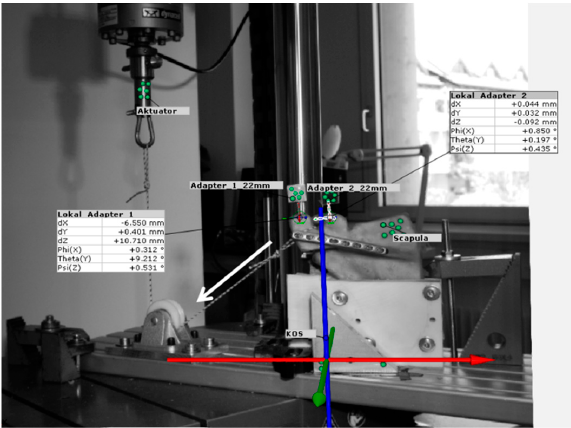
Figure 3. Test setup and superimposed 3D motion analysis. Stiffness and fragment movements of the acromial fragment were evaluated in the direction of the muscle pull of the deltoid muscle (white arrow). The co-ordinate system (blue, red, and green arrows) reflects the anatomical spatial planes.